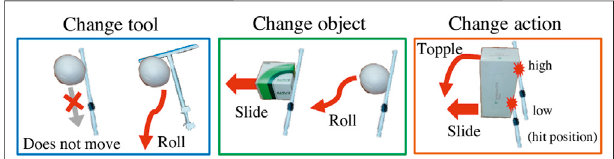
FIGURE 3 | Examples in which effects will differ by tools, objects, and actions.Intheleftpicture,eventhoughtheobjectandtheactionarethesame, the ball will not move if it is pulled with the I-shaped tool, but will roll if pulled with the T-shaped tool. In the middle picture, if we push left with the I-shaped tool, the box will slide but the ball will roll. In the right picture, even when using the same box and same I-shape tool, the effect of object behavior will differ depending on the height at which the robot pushes thebox, toppling if pushed at a high point or sliding if pushed at a low